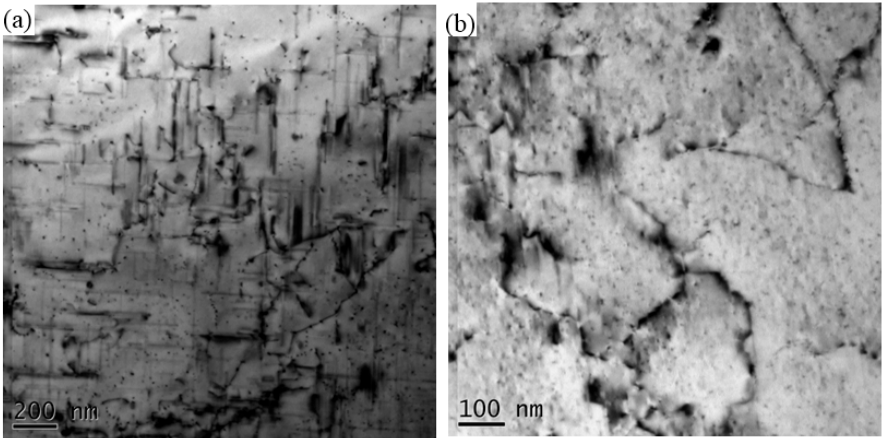
Figure 8. TEM of ( a ) HAZ and ( b ) TMAZ in retreating side (RS).